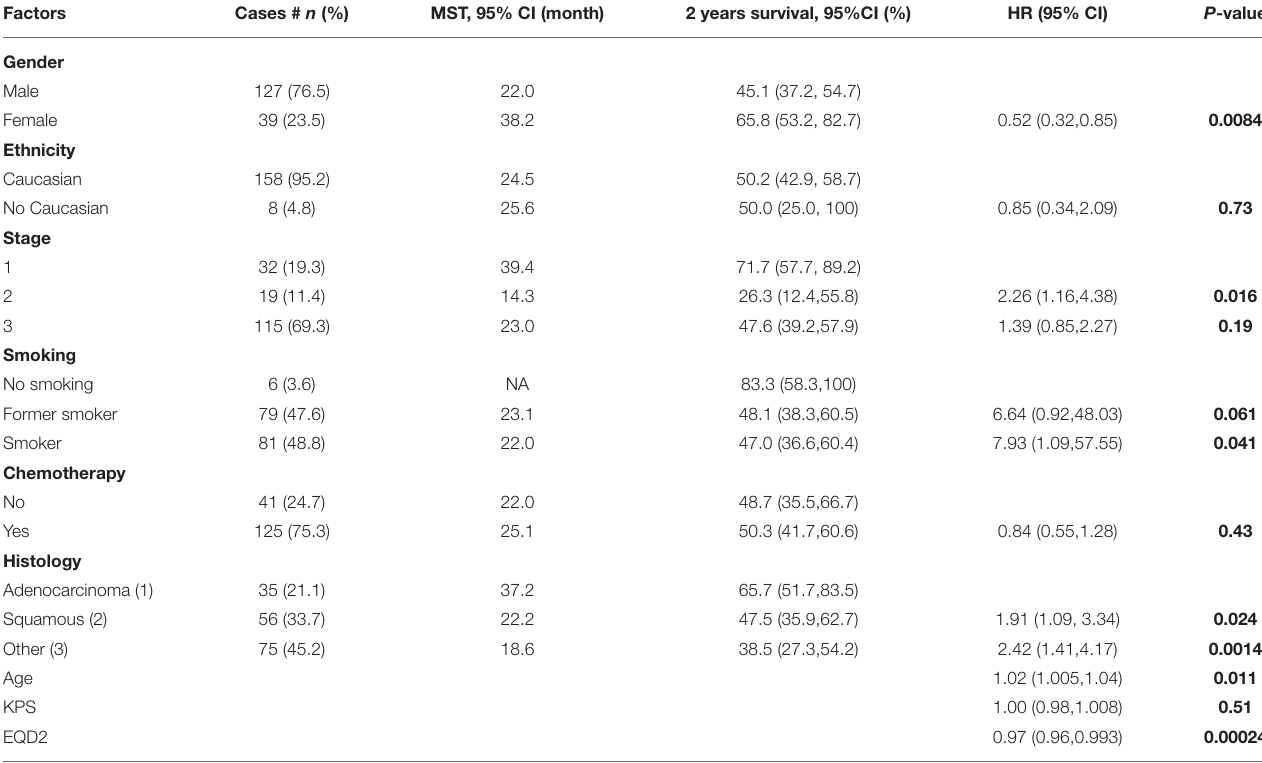
TABLE 1 | Selected clinical factors of NSCLC patient population.